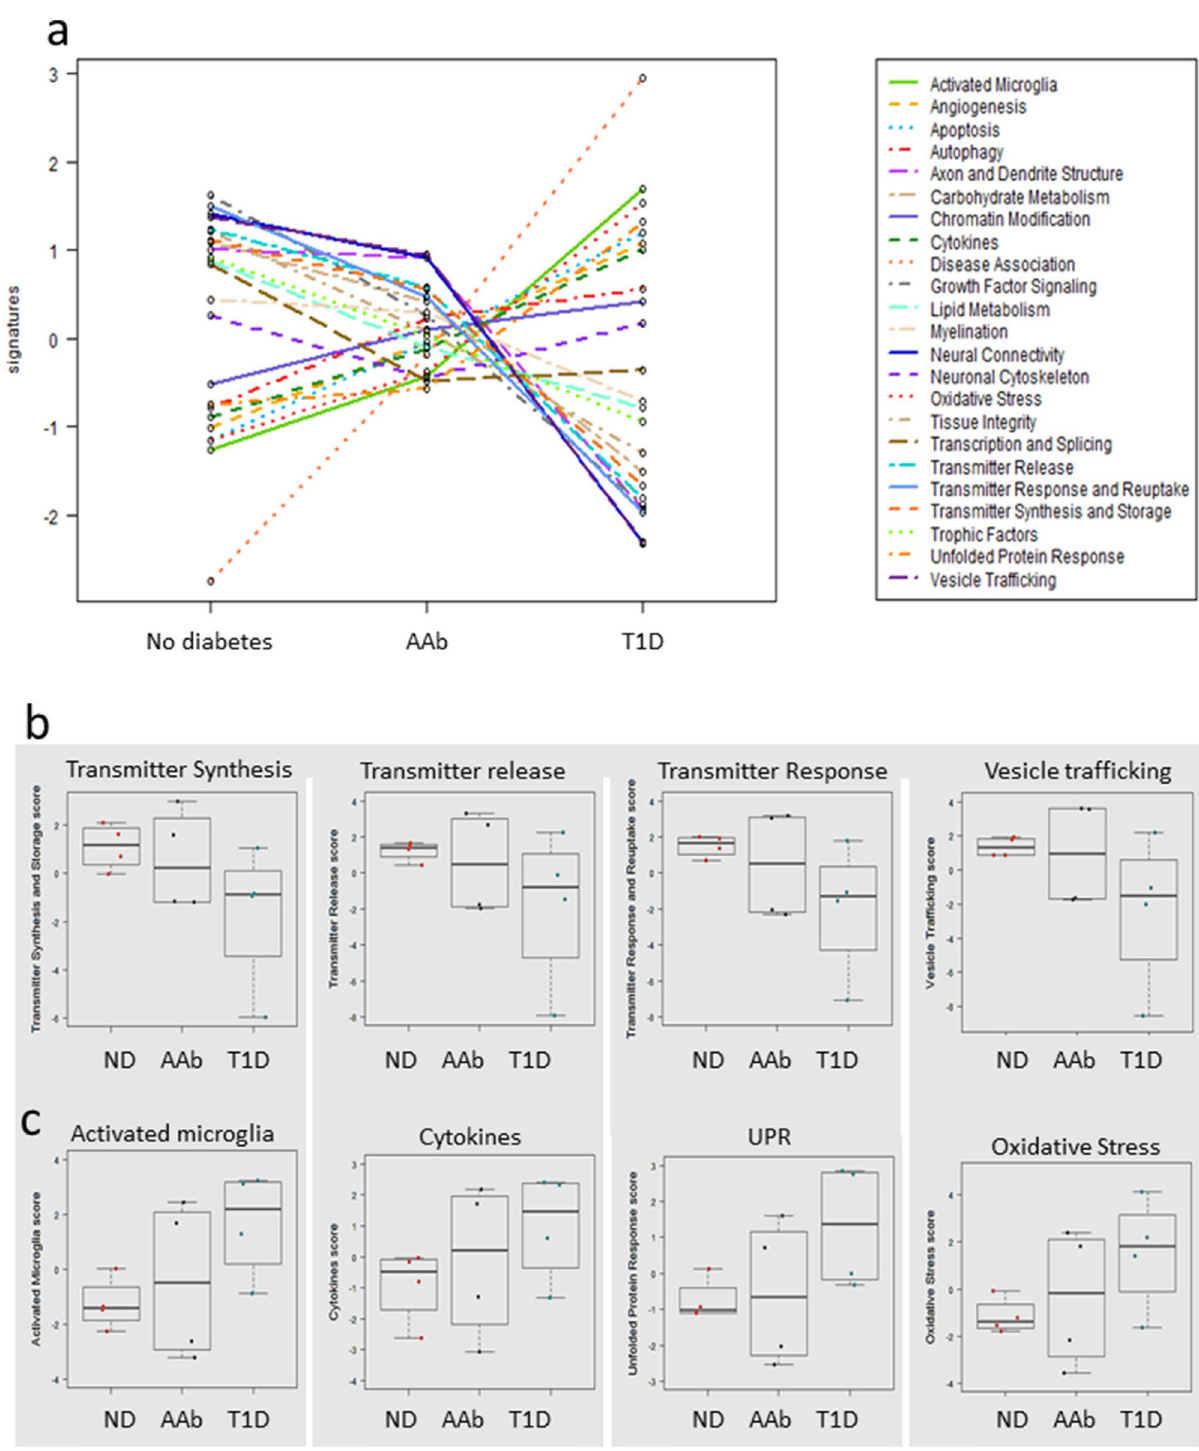
Figure 7. Islet neuropathology pathways in AAb and T1D donors. ( a ) Nanostring neuropathology pathways with significantly different gene regulation between the donor groups are shown by colored line plots with pathways listed in the side-box (n = 4 no diabetes, n = 4 Autoab Pos (AAb), n = 4 T1D donors). ( b ) Bar and whisker plots (median, range) of relative gene expression levels for transmitter synthesis and storage, transmitter release, transmitter response and update, and vesicle trafficking that were significantly downregulated in T1D donors. Donor types are ordered as in ( a ) ( c ) Bar and whisker plots (median, range) of relative gene expression levels for activated microglia, cytokines, unfolded protein response (UPR) and oxidative stress pathways that were significantly upregulated in T1D donors. See Supplementary Tables S6–7 for additional